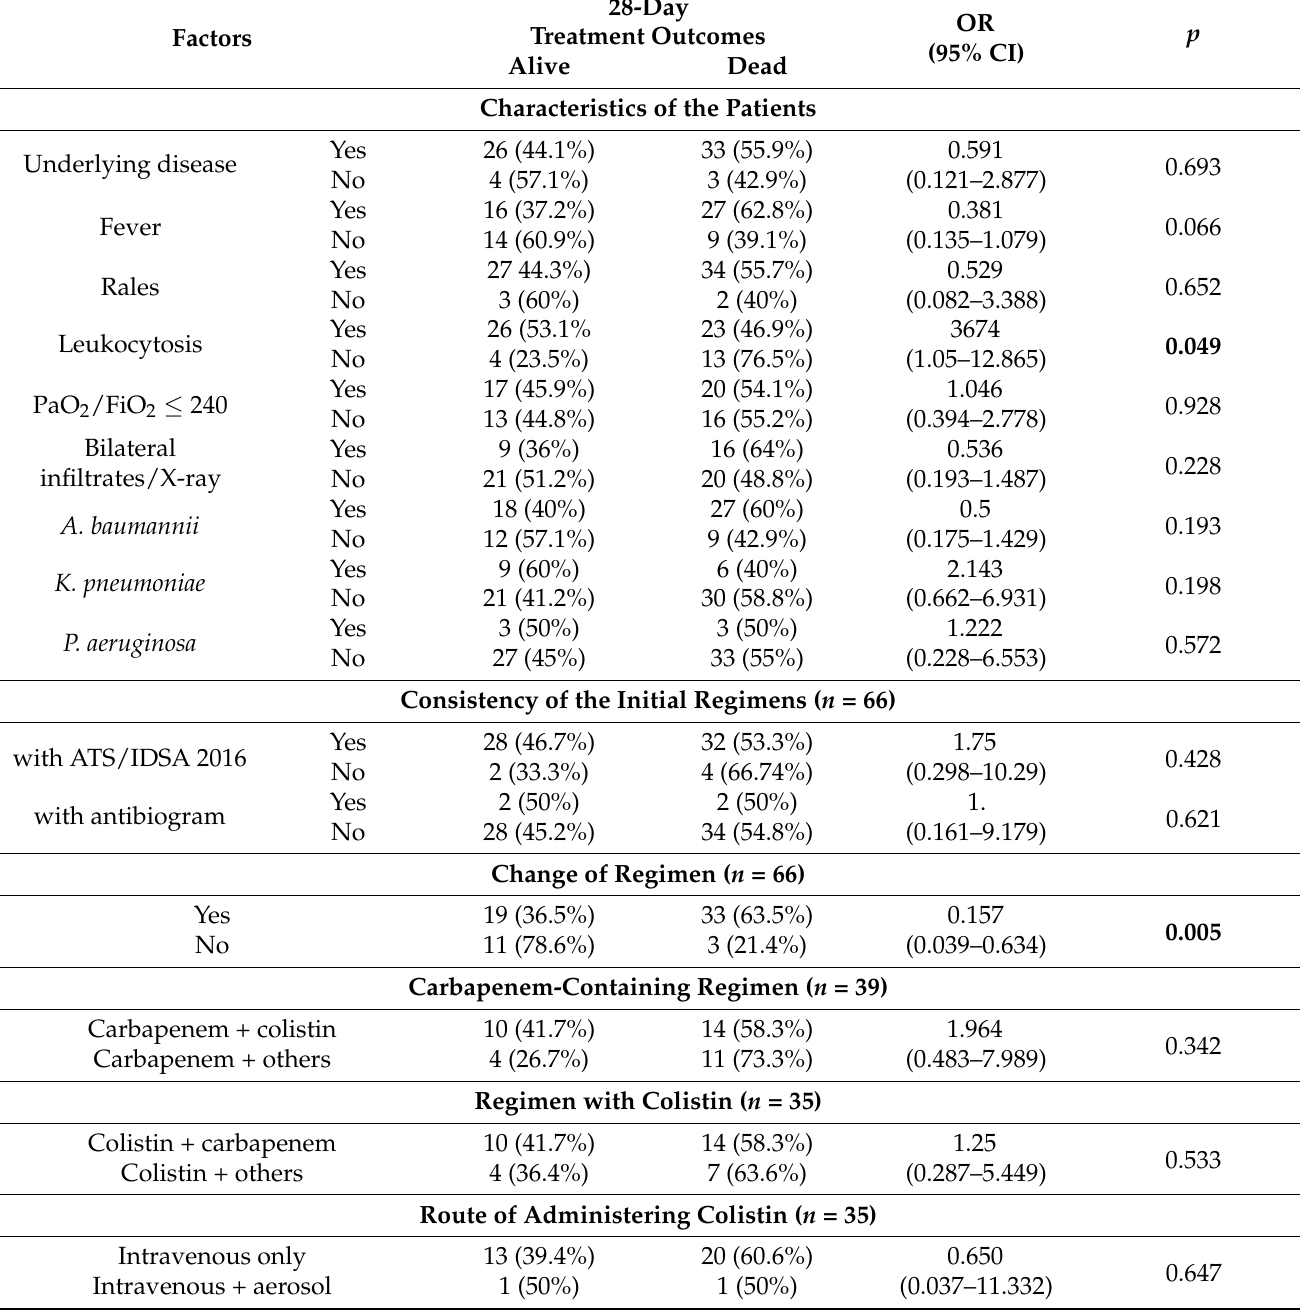
Table 7. Twenty-eight-day treatment outcomes and related factors ( n =